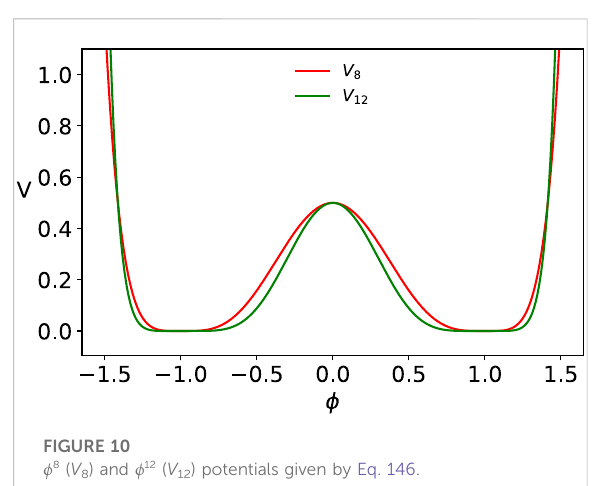
FIGURE 10 ϕ 12 ( V ϕ 8 ( V 8 ) and 12 ) potentials given by Eq.